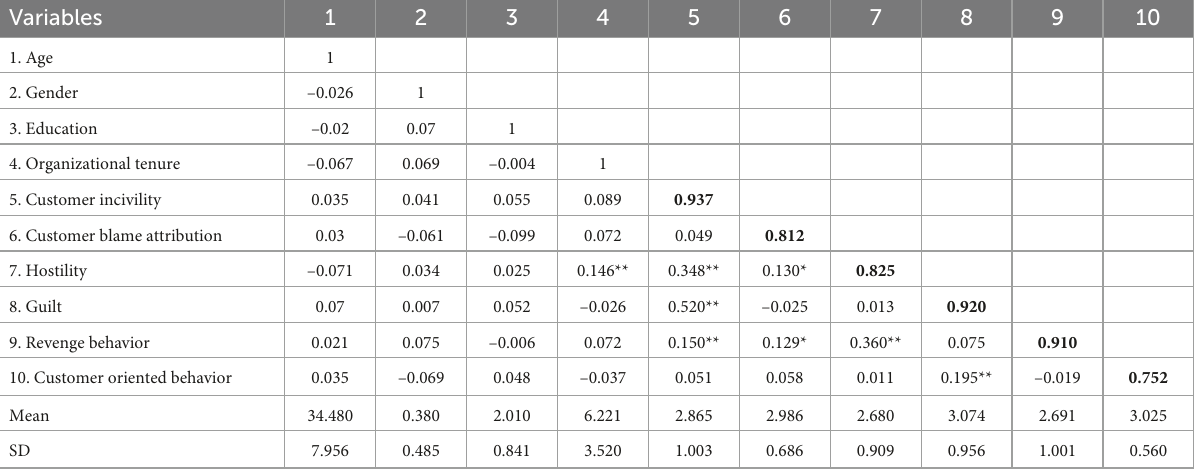
TABLE 2 Descriptive statistics and bivariate correlations among study variables.